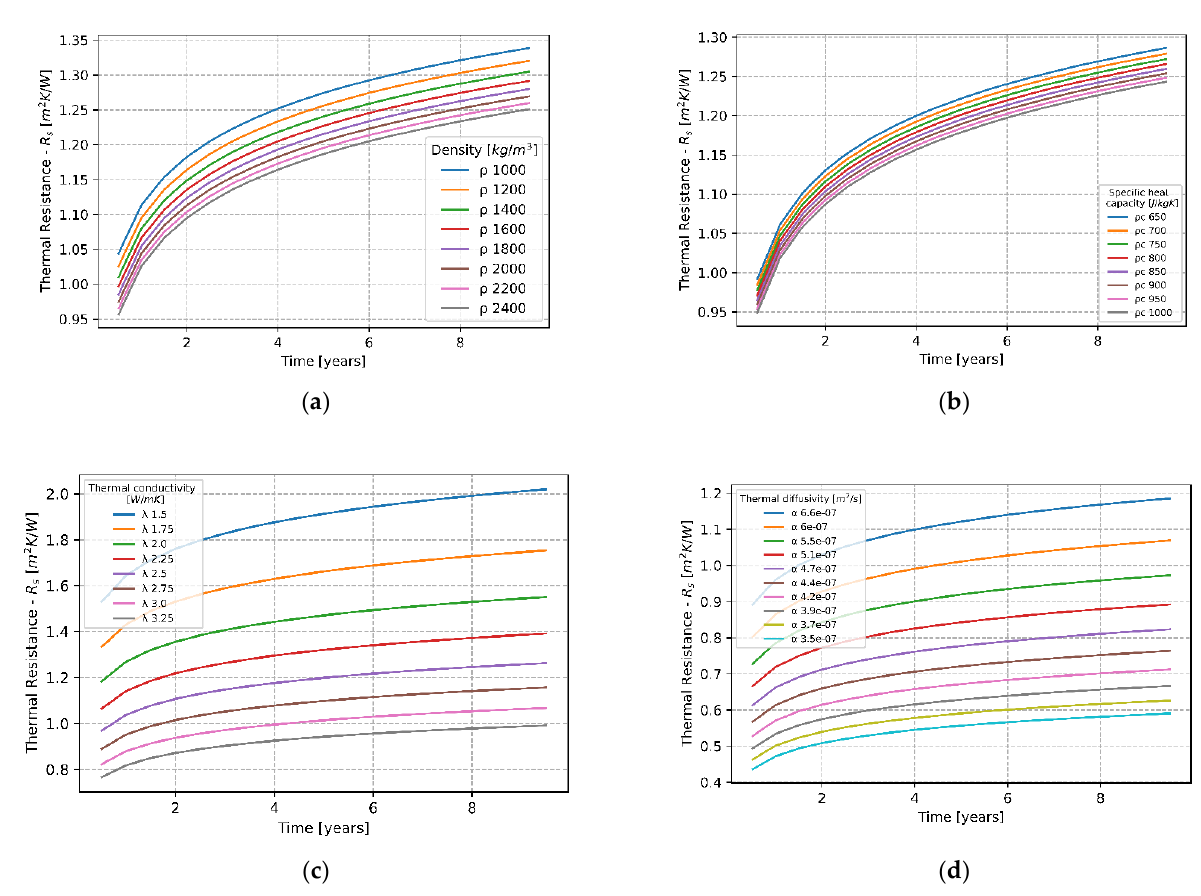
Figure 6. Soil resistance over time with different ground density ( ρ – kg/m 3 ) ( a ); specific heat (pc s rock – J/kg/K) ( b ); conductivity ( λ s – W/mK) ( c ); thermal diffusivity (α) ( d ).